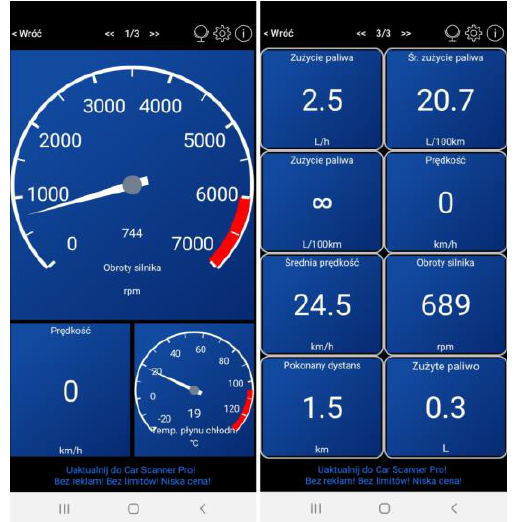
Fig. 5. Example of real-time preview of engine operating parameters using the "Car Scanner"